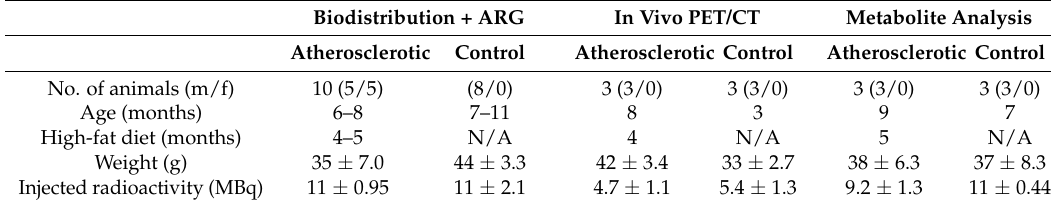
Table 3. Details of the studied